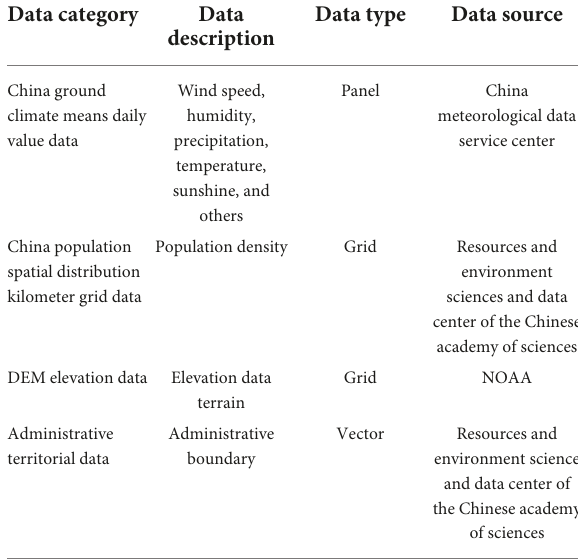
TABLE 1 Regional classification of China. TABLE 2 Data sources and